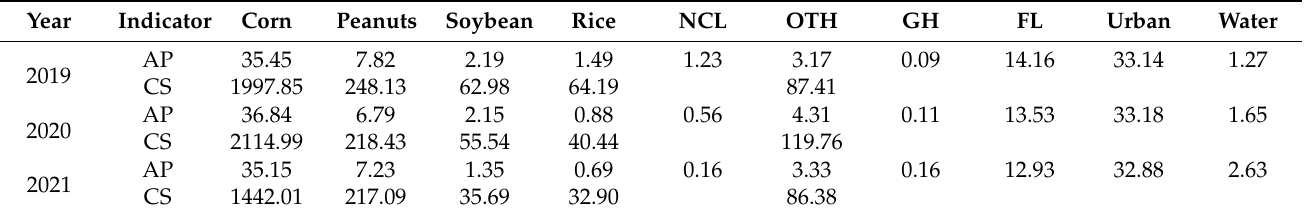
Table 6. Estimation of crop area and carbon sequestration. Area proportion and carbon sequestration are abbreviated as AP and CS. The units of area and CS area % and thousand